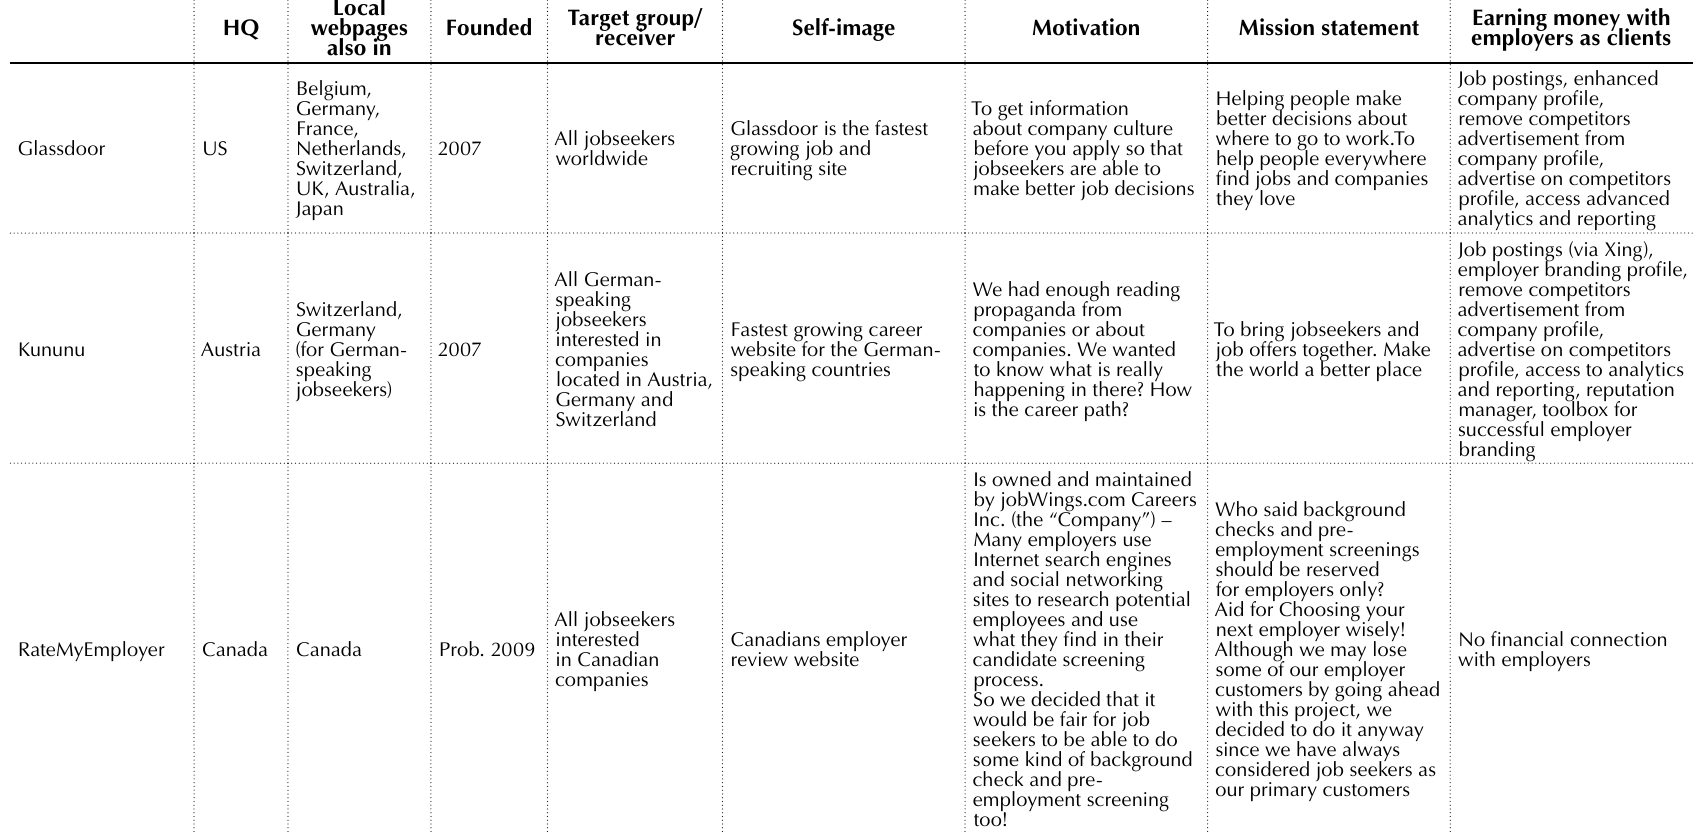
Table 1. Social Structure of Job Review